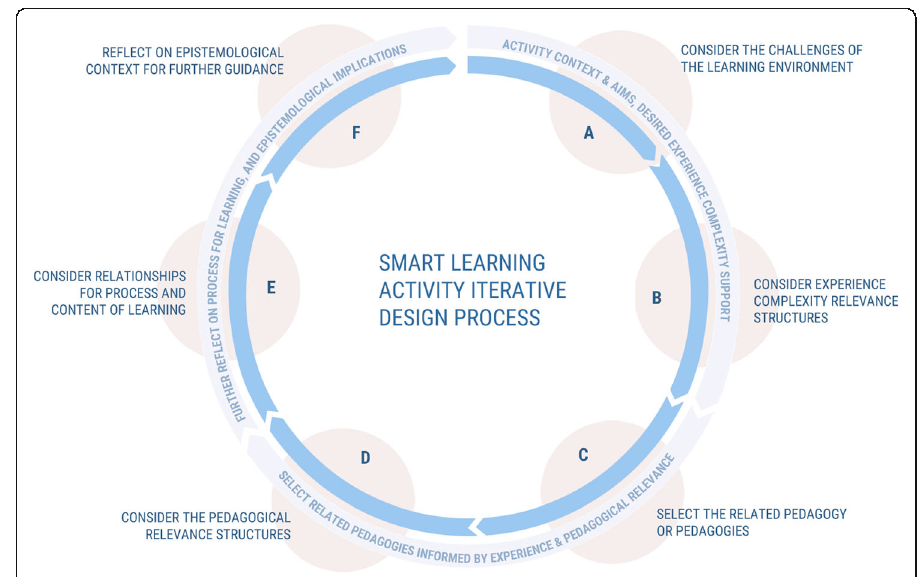
Fig. 2 Interpretation of the PECSL design iterative process, after Design 101 (Gibbons,